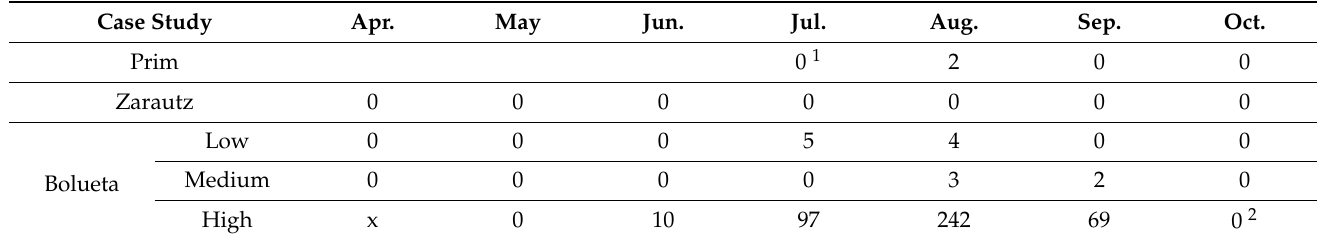
Table 9. Number of hours where T > 28 ◦ C, April–October 2020.